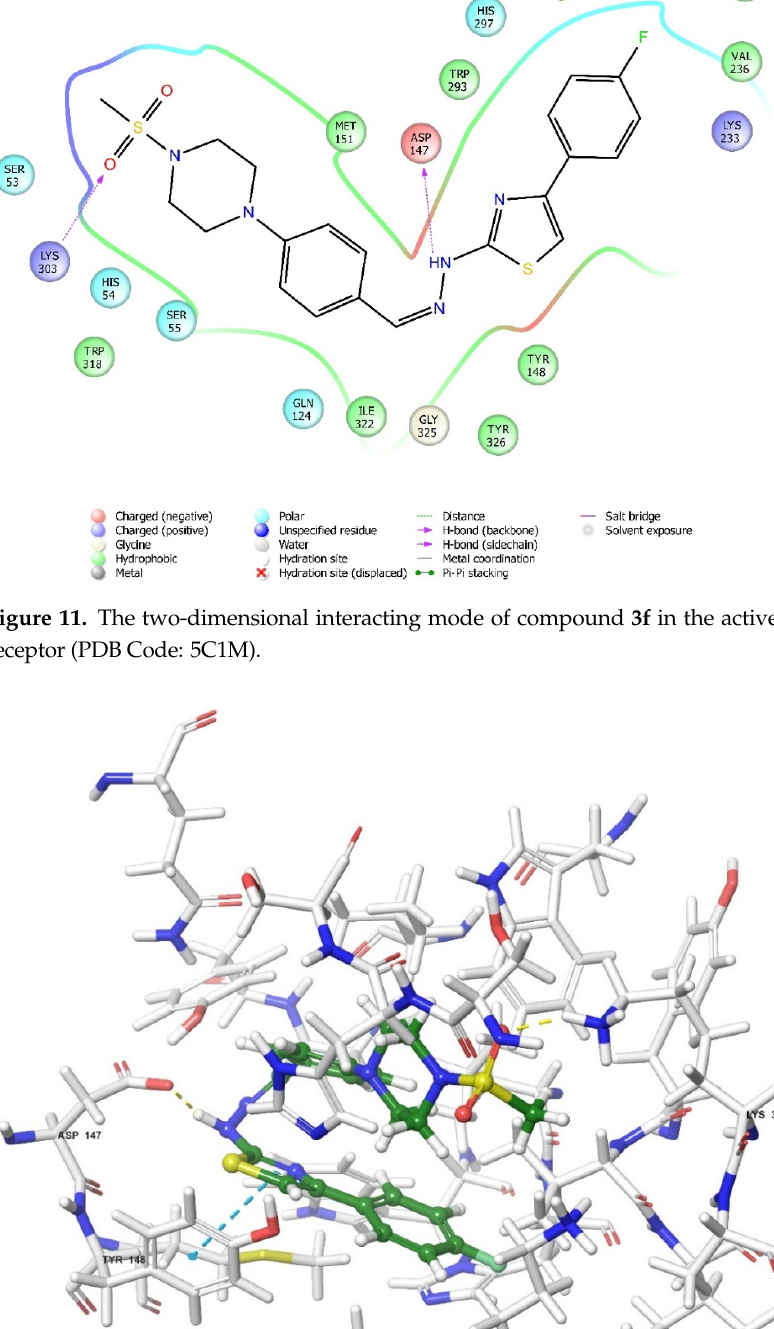
Figure 10. The three-dimensional pose of the interaction of all compounds with the µ-opioid re- ceptor (PDB Code: 5C1M) active site. The inactive compounds ( 3d , 3e , and 3h ) are presented by a tube model colored with red.